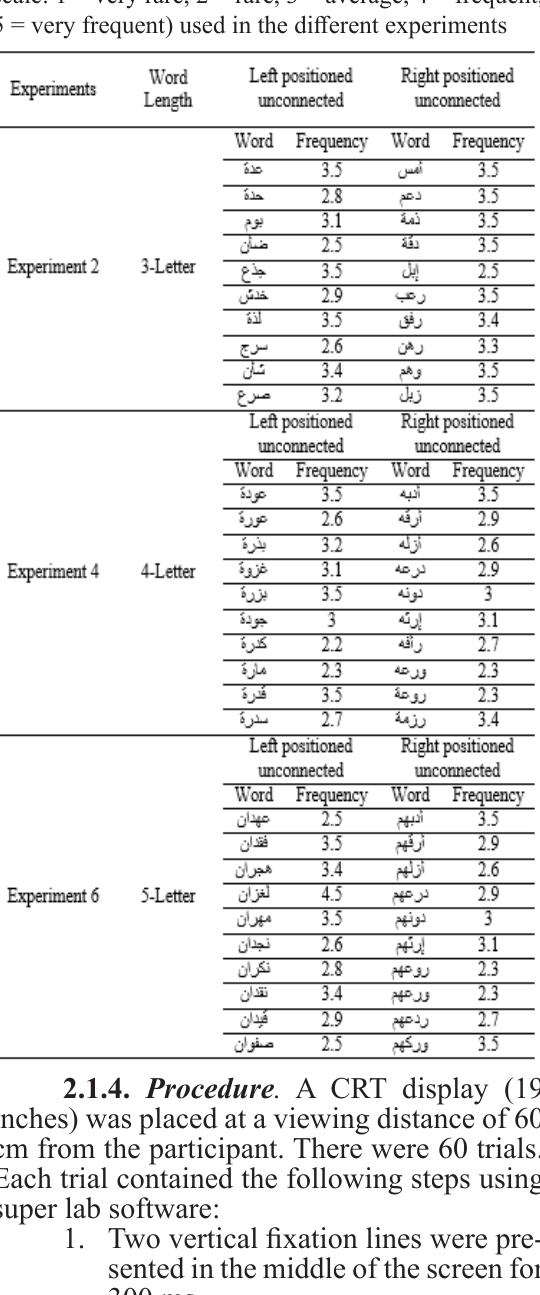
Table 4. Word Stimuli and frequency